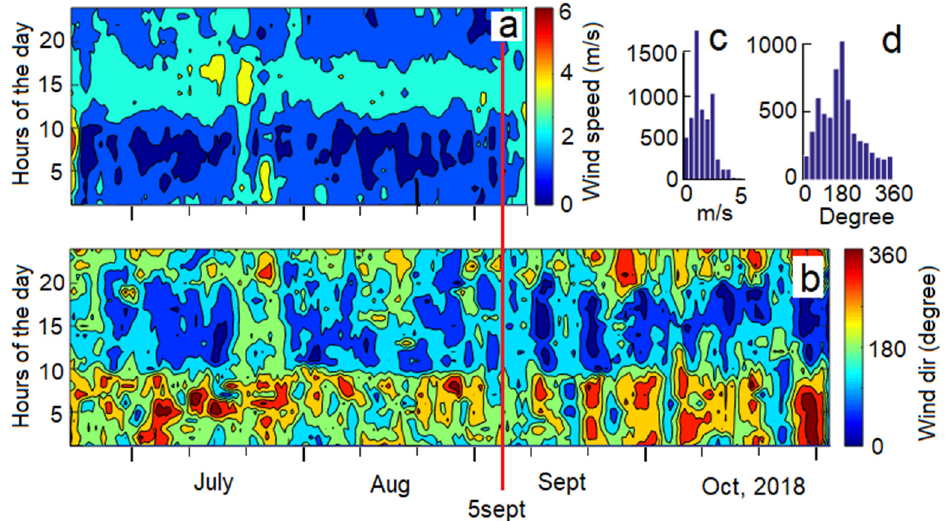
Figure 6. Hourly variability of speed ( a ) and wind direction ( b ) measured at the floating weather station located in the center of Lake El Sol. ( c , d ) Representations of the histograms of ( a , b ). The red vertical line shows the day for which the numerical modeling of fluctuations of currents and the level of Lake El Sol was carried out.